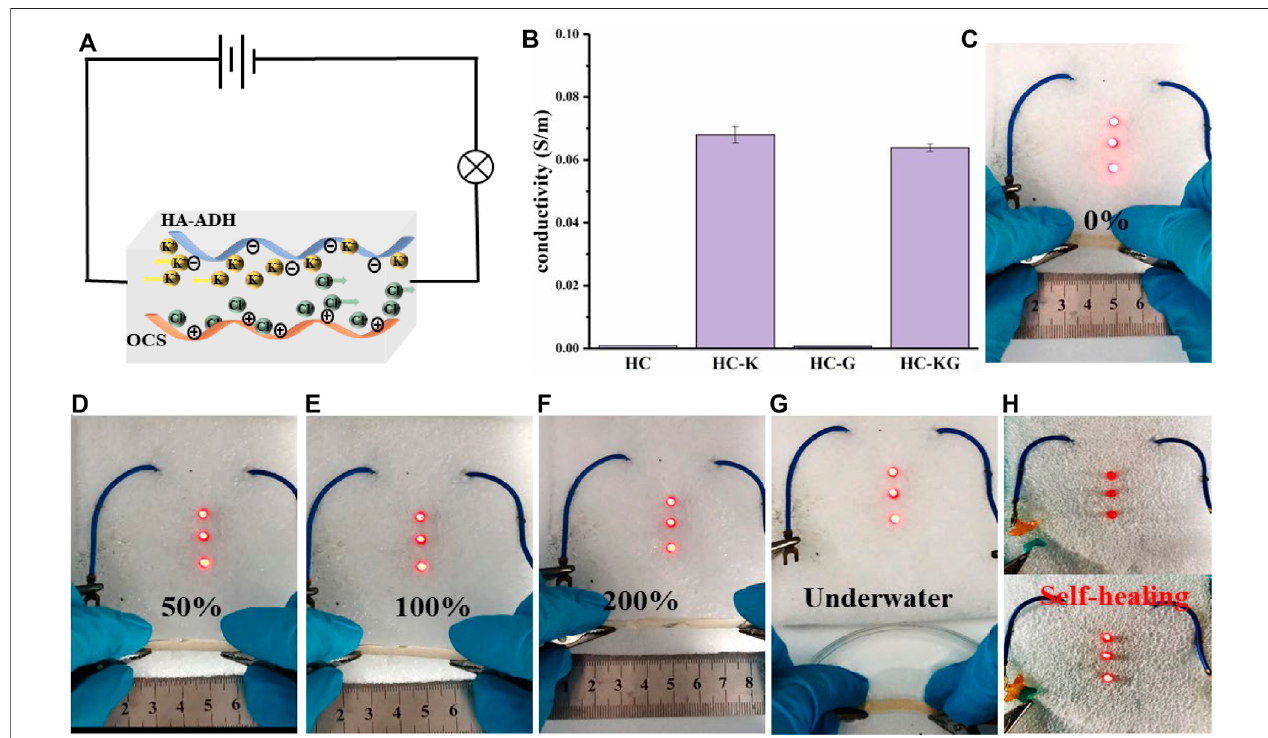
FIGURE3| Conductivepropertiesof the series hydrogelbased on HA-ADHand OCS. (A) Directionalmovement of ions in hydrogelsunder electri fi cation. (B) Quantitative conductivity of HC, HC-K, HC-G, and HC-KG hydrogel. The HC-KG hydrogel could be applied as a fl exible electric wire to lighten the LEDs under different elongation of 0% (C) , 50% (D) , 100% (E) , and 200% (F) . (G) HC-KG hydrogel also could be applied as a fl exible electric wire under water condition. (H) HC-KG hydrogel still exhibited good conductivity after its